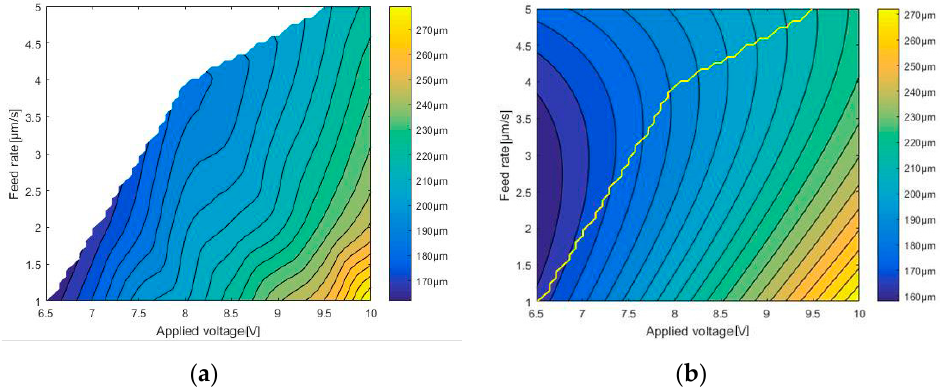
using Equation (1); ( c ) fitting error between (a) and (b). Equation (1); ( c ) fitting error between (a) and (b).